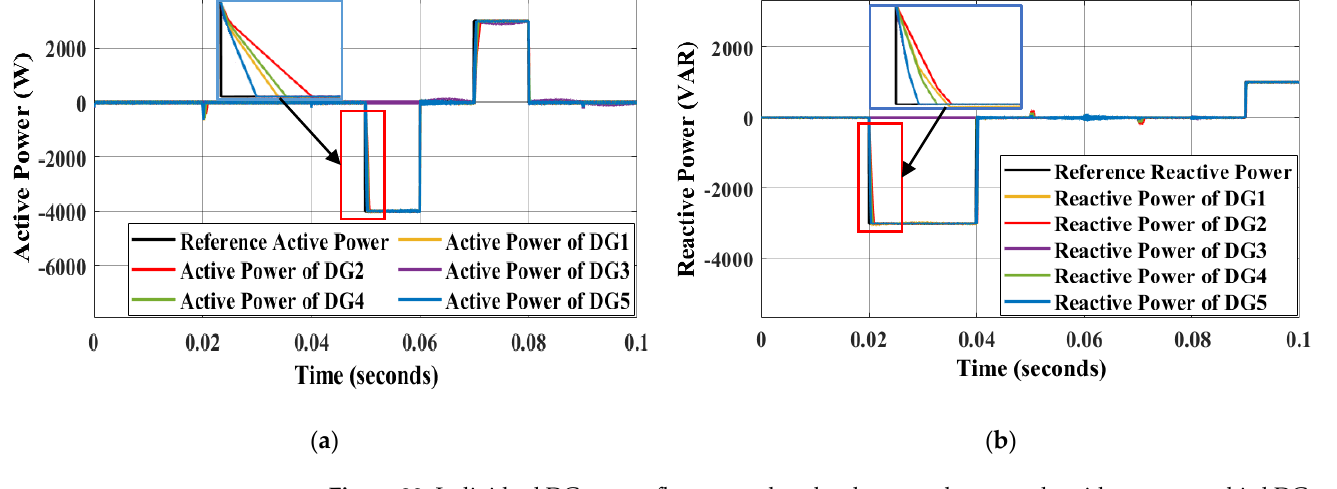
Figure 20. Individual DG power flow control under the second case study with an outage third DG: